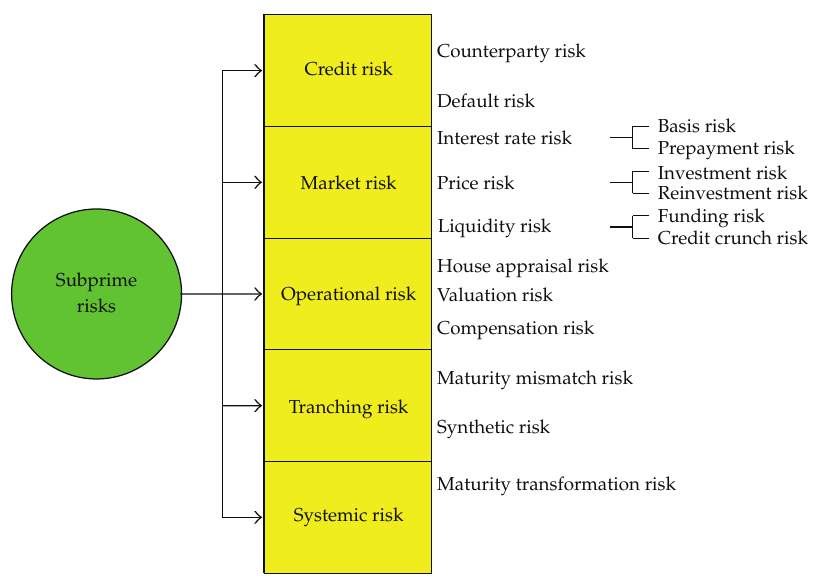
Figure 3: Diagrammatic overview of subprime